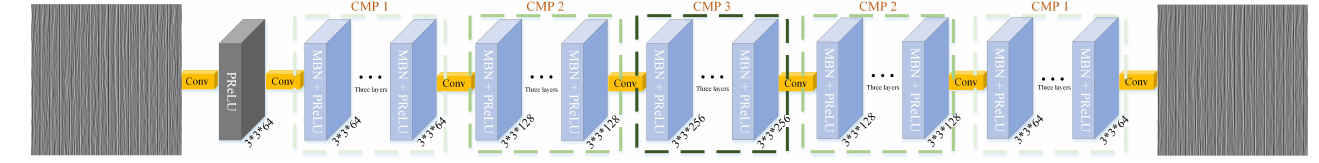
Figure 4. Flowwork of the proposed stripe estimation